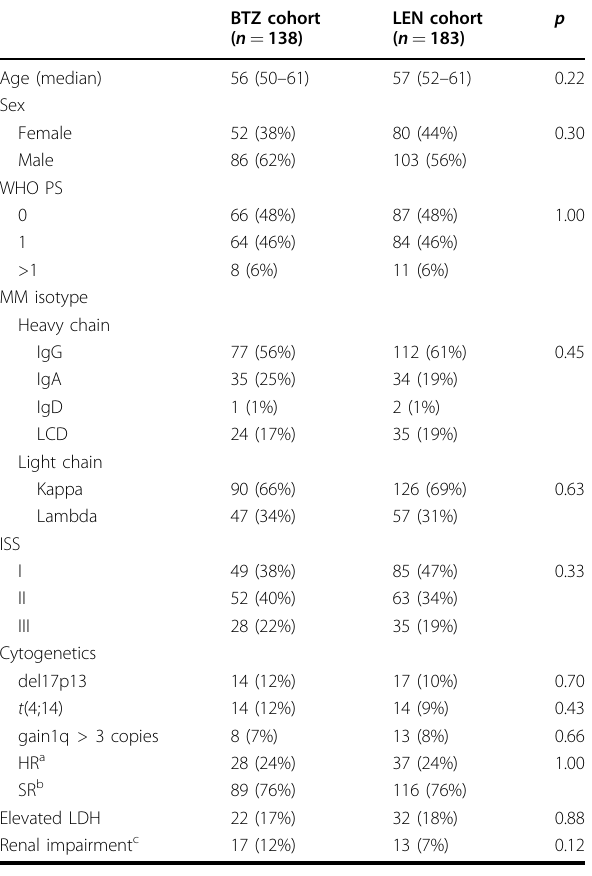
Table 1 Baseline characteristics at the time of treatment initiation, i.e., before bortezomib-based induction